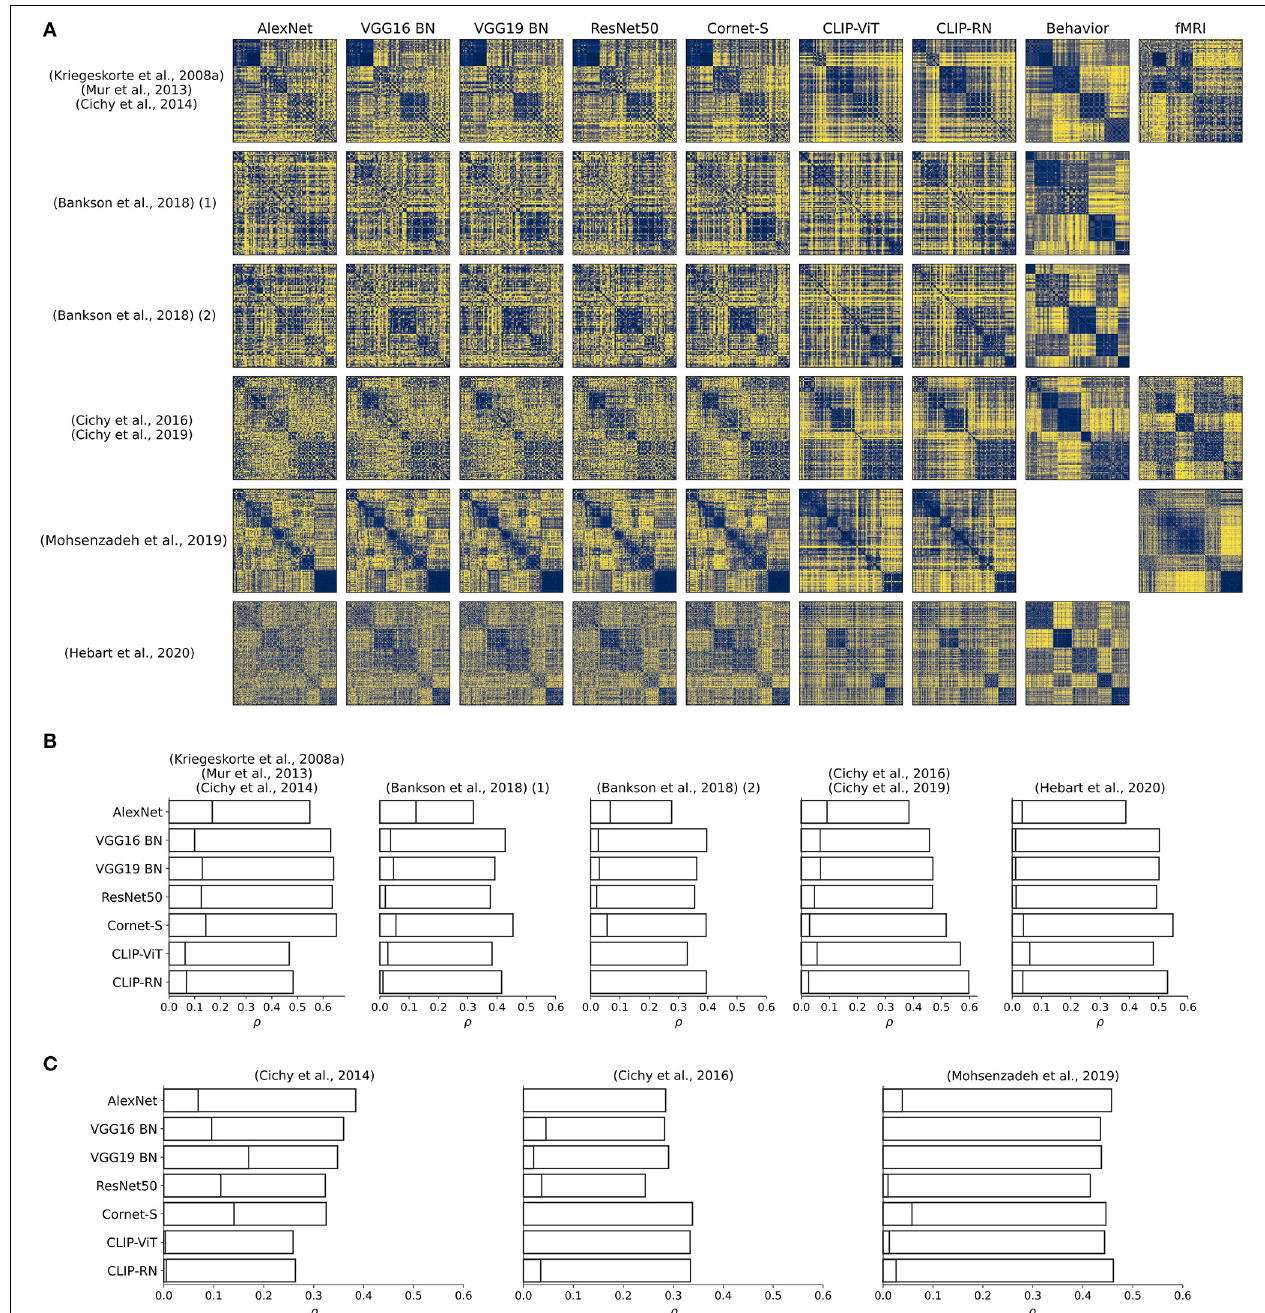
FIGURE 2 | (A) RDMs for penultimate layer representations of different pretrained neural network models, for group averages of behavioral judgments, and for fMRI responses to higher visual cortex. For Mohsenzadeh et al. (2019), no behavioral experiments had been conducted. For both datasets in Bankson et al. (2018), and for Hebart et al. (2020), no fMRI recordings were available. For display purposes, Hebart et al. (2020) was downsampled to 200 conditions. RDMs were reordered according to an unsupervised clustering. (B,C) Pearson correlation coefficients for comparisons between neural network representations extracted from the penultimate layer and behavioral representations (B) and representations corresponding to fMRI responses of higher visual cortex (C) . Activations were extracted from pretrained and randomly initialized